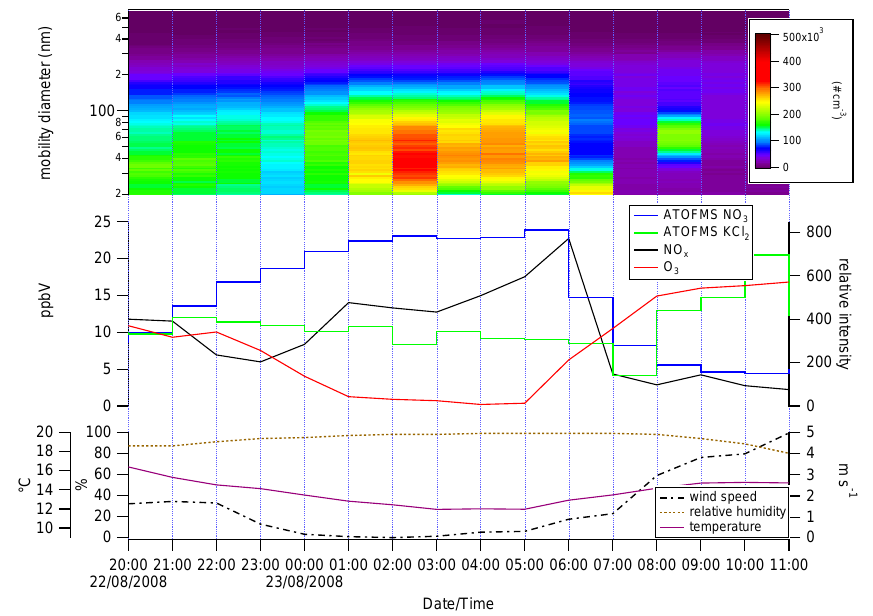
Fig. 8. Top panel: hourly integrated size resolved SMPS particle counts. Middle panel: hourly averaged ATOFMS signal for [NO 3 ] − and [KCl 2 ] + , hourly averaged mixing ratios for NO x and O 3 . Bottom panel: hourly averaged wind speed, relative humidity and temperature.